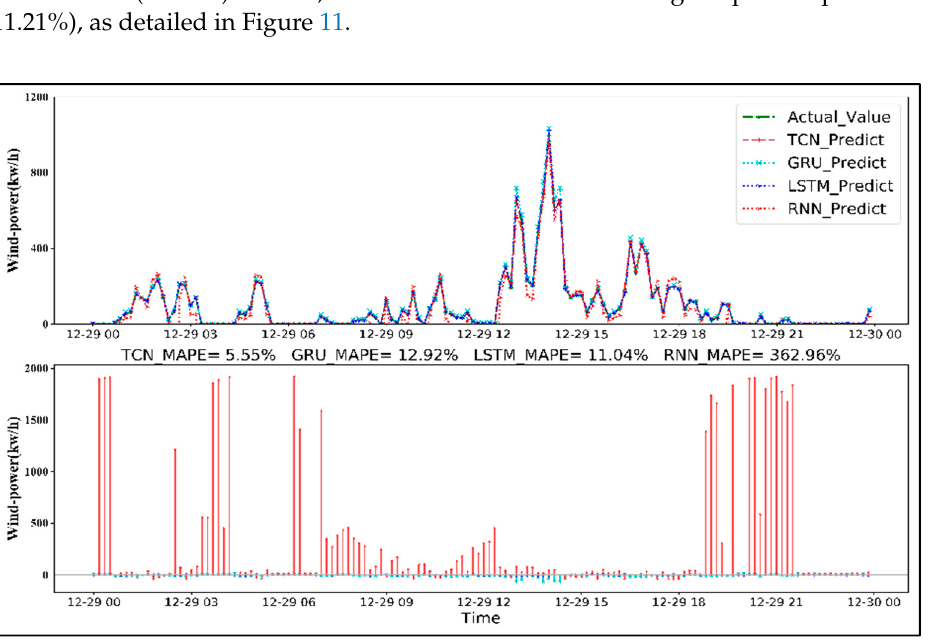
Figure 12. 24-h wind power forecasting (Experiment II).